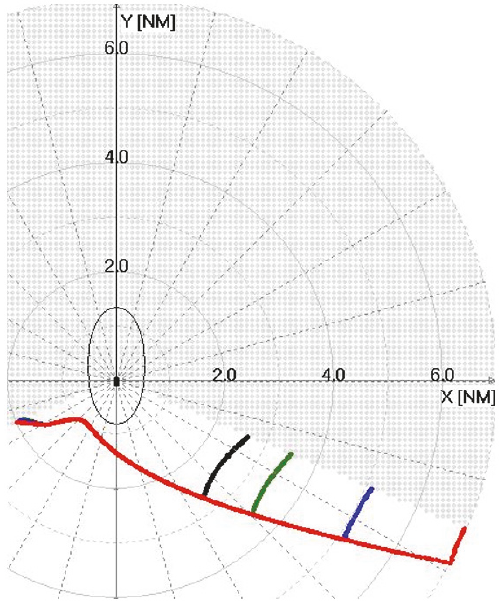
Figure 16: Action lines for being overtaken by a target, whose true speed is 23 knots. Assumed are turns of 15 ∘ to starboard without speed reduction (red) or with speed reduced by 3 knots (blue), 6 knots (green), and 9 knots (black).